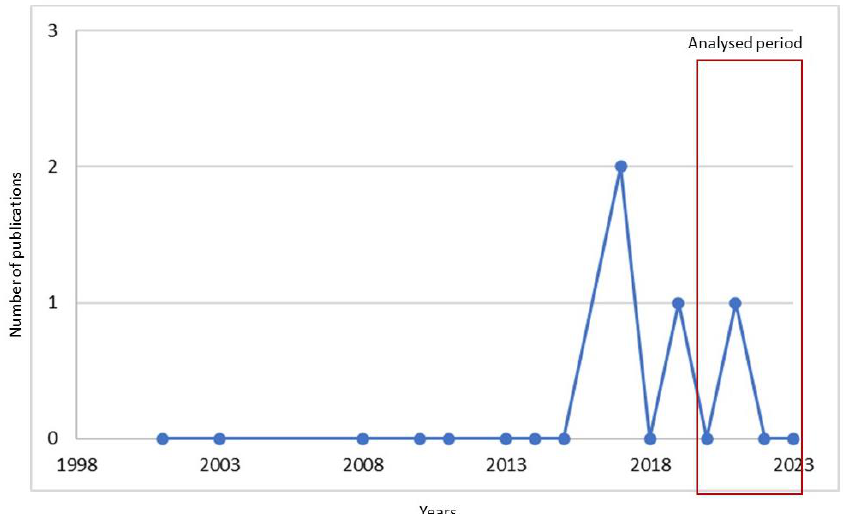
Figure 17. Chronological view of the studies on geothermal energy and architectural heritage: 4 scientific documents have been realized from 2017 to 2023, 1 of them in the years 2020–2023 (Source: Author’s elaboration using Scopus data).